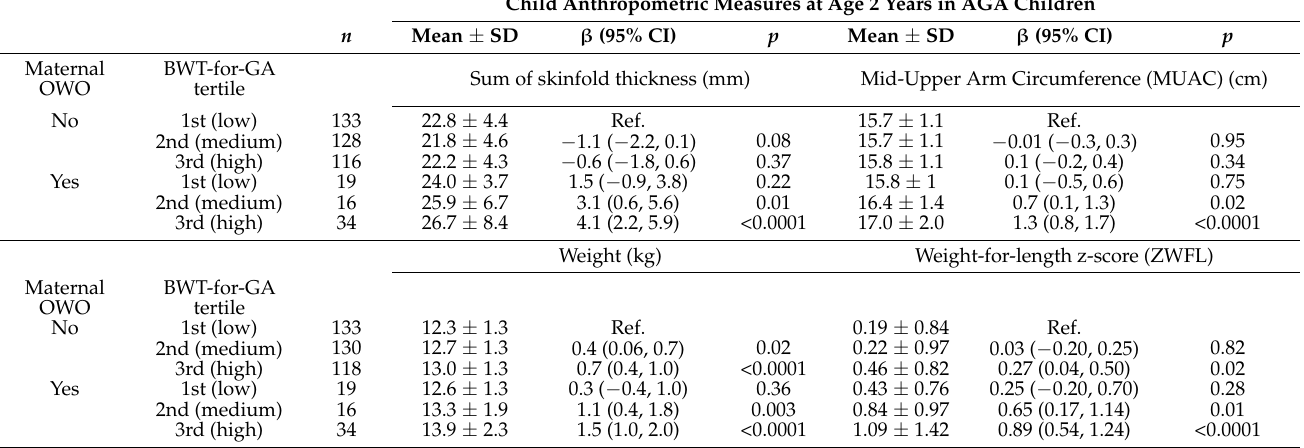
Table 3. The association between gestational age-specific tertiles of birthweight (BWT-for-GA ter- tile) and maternal prepregnancy overweight or obesity (maternal OWO) and child anthropometric measures of body composition in term AGA children at 2 years of